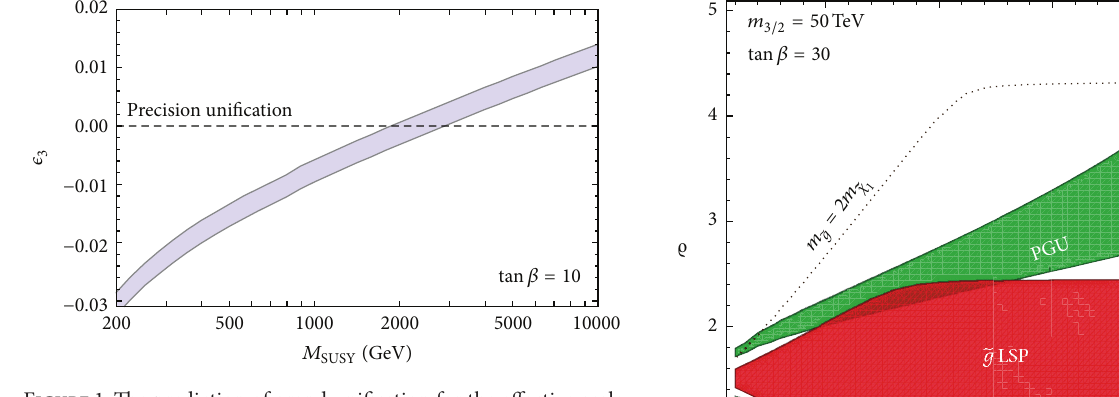
Figure 2: Parameter scan in the (𝜇,󰜚) -plane for fixed 𝑚 50 TeV. The regions where the gauge couplings unify within the experimental error on the strong coupling are shown in green. In the upper region, the lightest neutralino is predominantly of bino- type, where the lower one corresponds to a wino-like LSP. The red region exhibits a gluino LSP. The dotted contour indicates where the mass ratio between gluino and LSP becomes